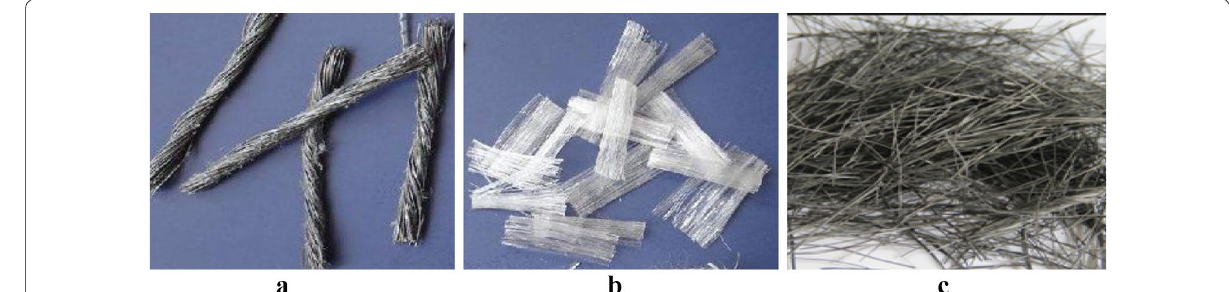
Fig. 4 Macro synthetic fiber: a PP Twist fiber; b PP mesh fiber; c PE fiber.